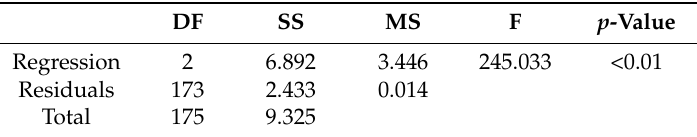
Table 7. Results of ANOVA analysis.